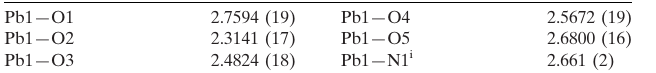
Selected bond lengths (A˚ ).